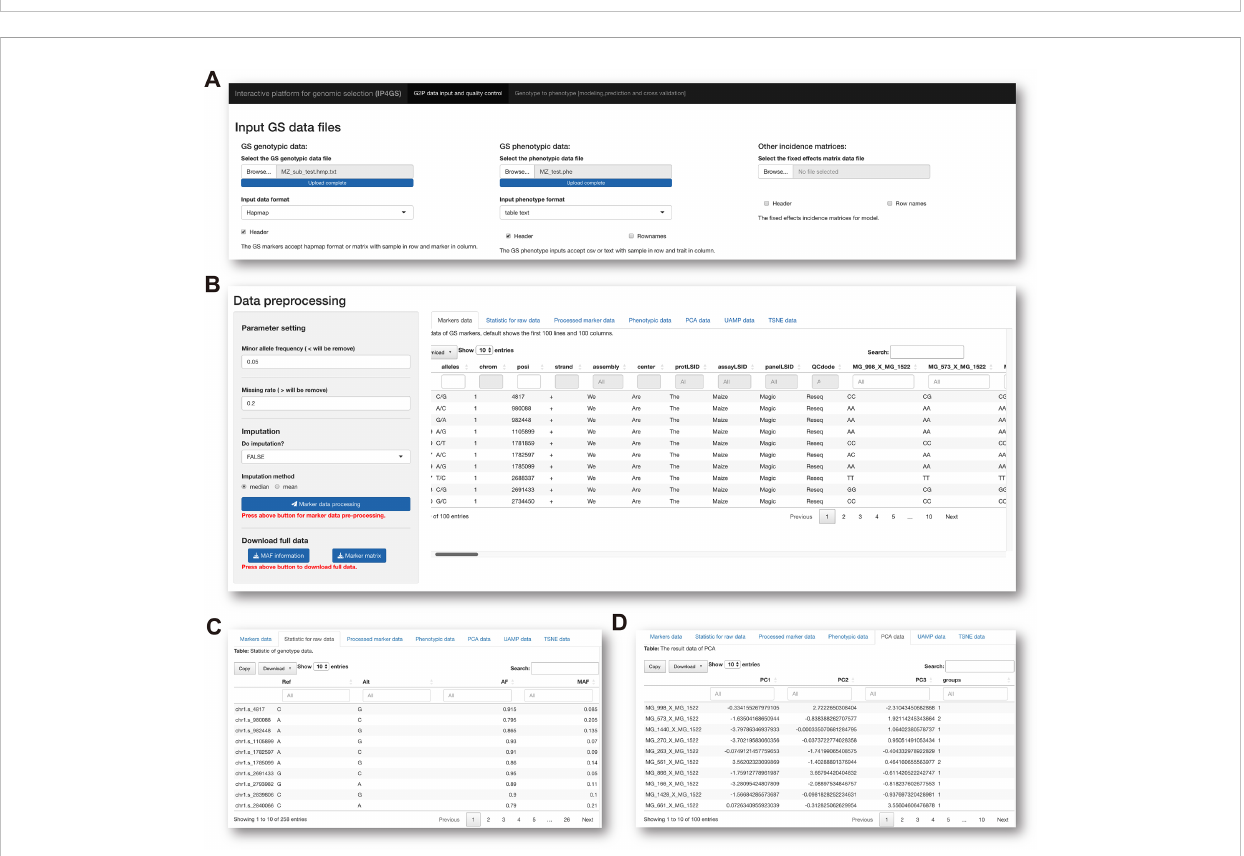
FIGURE 2 Preprocessing of genotypic data. (A) IP4GS accepts genotypic data in HapMap, Matrix, and Custom fi le formats, phenotypic data in CSV and tab-delimited text formats, and an optional fi le including features as fi xed effects. (B) Control console for genotypic data fi ltration (left) and display window for preview of a variety of data tables (right). (C) Preview of processed genotypic data with statistics for MAF, AF, and MR for each SNP. (D) Preview of DR data generated by PCA, UMAP, and t-SNE